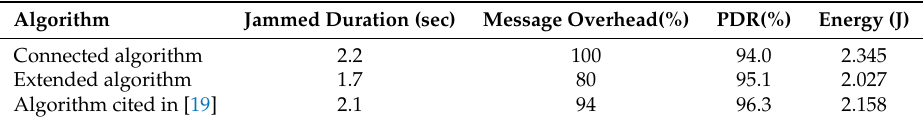
Table 8. Comparison of the algorithms: presented in this work and the cited in